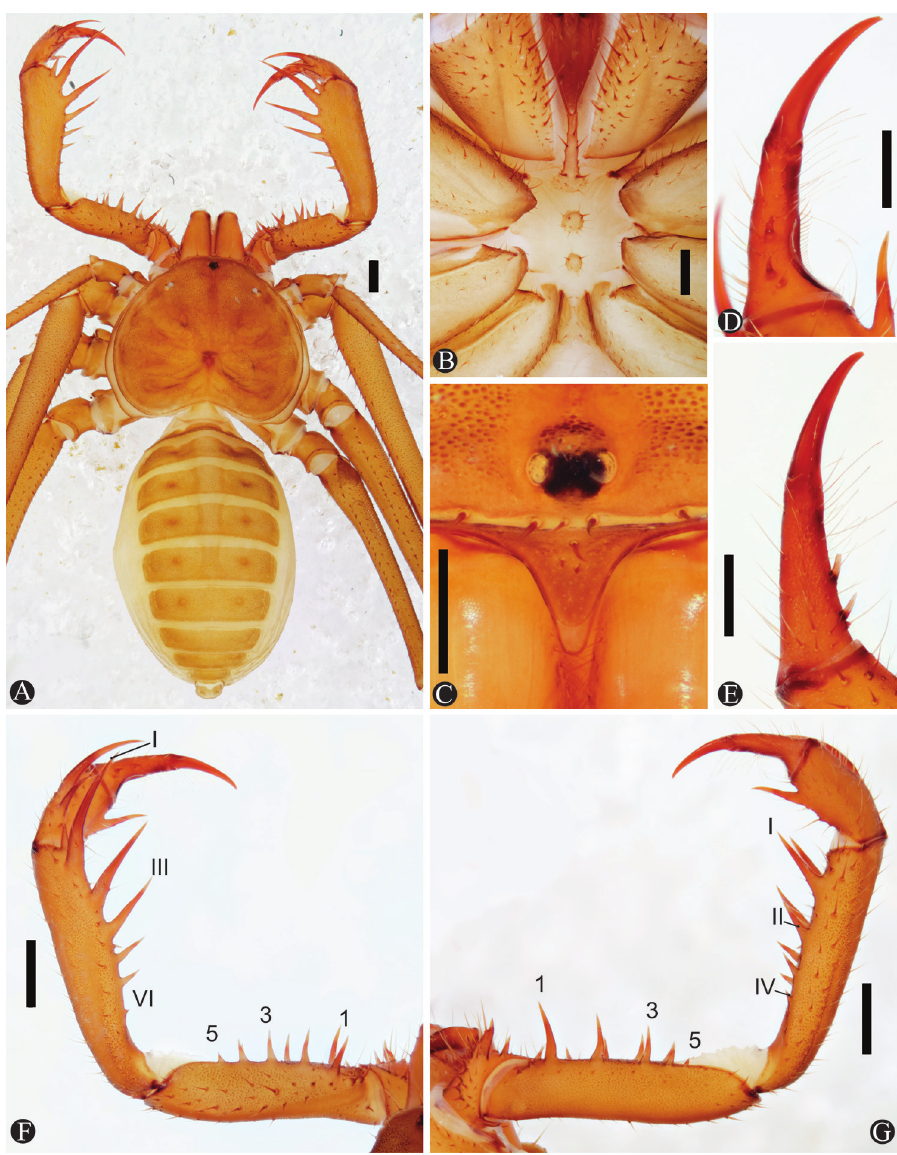
Figure 1. Habitus and details of Charinus ruschii sp. n. (holotype, MNRJ 9235). A Habitus dorsal B Sternum C Frontal process D Dorsal view of left pedipalp tarsus and claw E Frontal view of left pedipalp tarsus and claw F Dorsal view of left pedipalp G Ventral view of left pedipalp. Scale bars: A, F, G : 1 mm; B, C, D, E : 0.5